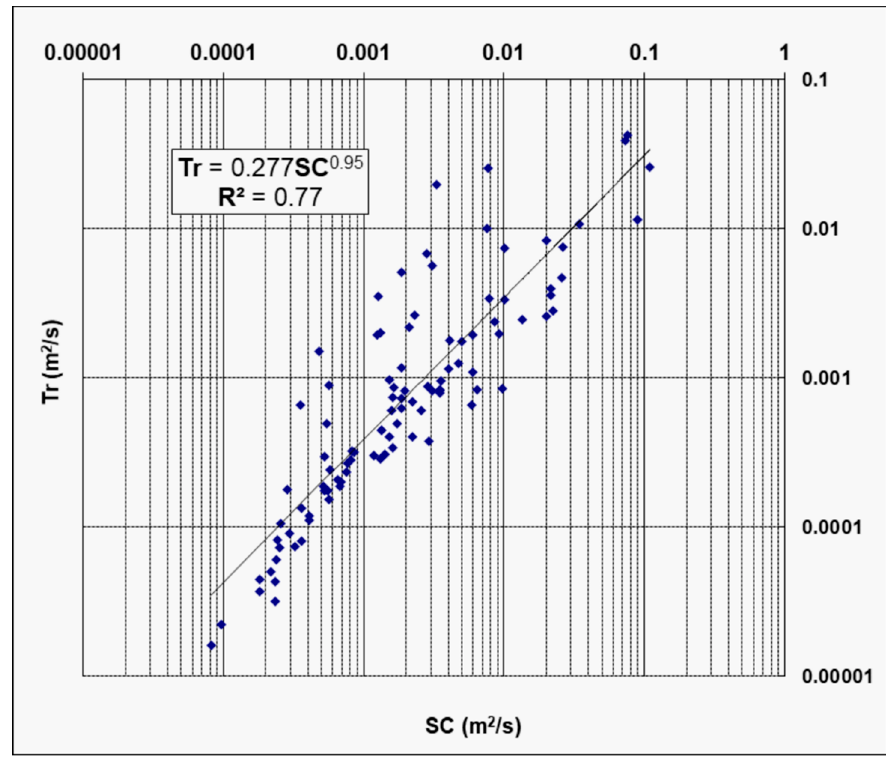
Figure 4. Log-log plot of specific capacity (SC) versus the recovery test (Tr) for tests that showed steady-state condition.